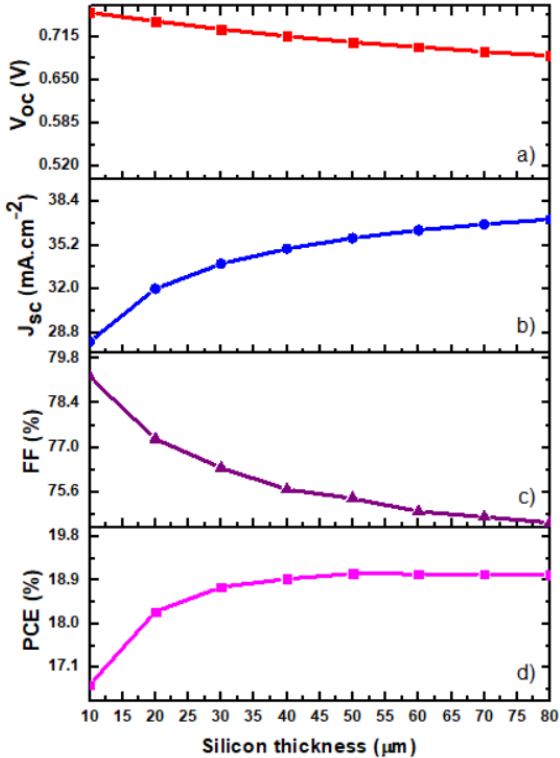
Figure 6. Effect of absorber layer thickness on the solar cell parameters.